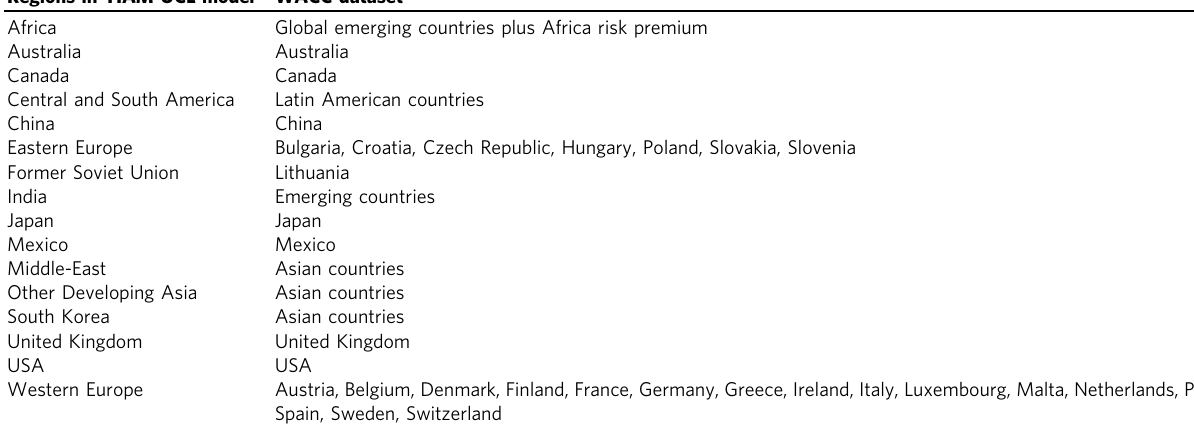
The WACC for Africa is computed as the sum of the WACC in global emerging countries plus an extra country risk premium (5%) to better re fl ect African countries risk premiums ’ median values 27 .